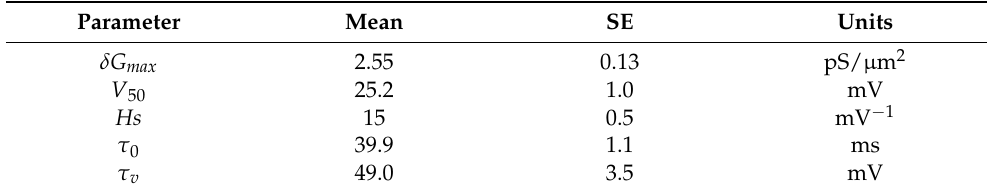
Table 1. Parametric values of potassium currents from cells in MEMs. Values obtained from a sample of 32 cells in MEMs. Parameter Mean SE Units δ G